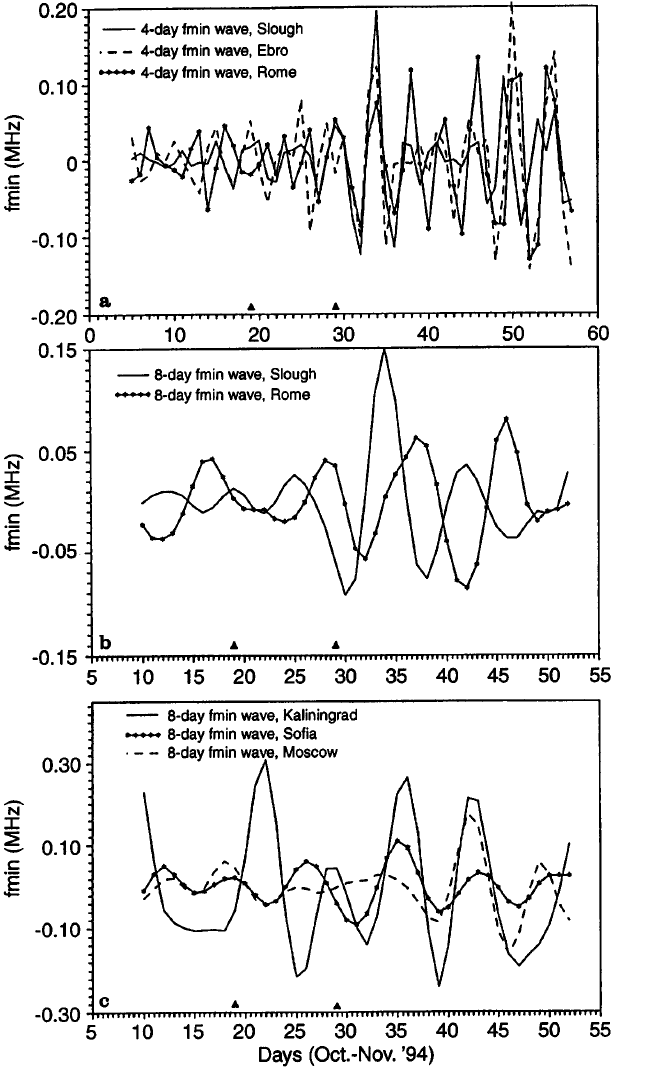
Fig. 3a–c. Filtered f data for the European stations: a (cid:24) 4-day min waves observed at the stations Slough ( solid line ), Ebro ( dashed line ) and Rome ( solid line with asterisks ); b (cid:24) 8-day waves observed at Fig. 4. MEM spectra in the period interval 3–25 days for ionosonde Slough ( solid line ) and Rome ( solid line with asterisks ), and c (cid:24) 8-day stations a Yamagawa ( solid line ), Kokubunji ( longer dashed line ), waves observed at Kaliningrad ( solid line ), Sofia ( solid line with aster- Okinawa ( solid line with asterisks ) and Beijing ( dashed line ), and isks ) and Moscow ( dashed line ). SSCs are marked by solid triangles